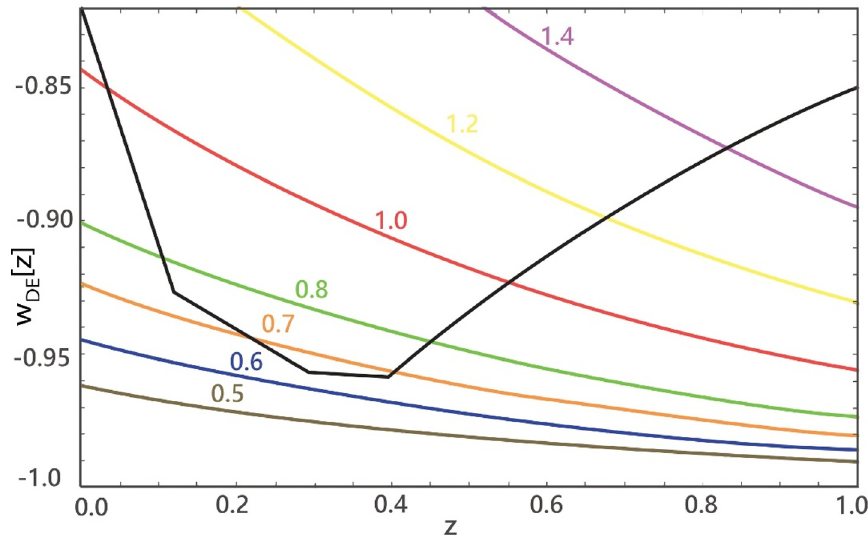
Figure 1 . The black curve shows the current observational 2 (cid:27) bound on w DE ( z ) for redshifts 0 < z < 1 based on SNeIa, CMB and BAO data [27]. This is compared with the predicted w DE ( z ) for exponential quintessence potentials with di(cid:11)erent values of constant (cid:21) under the constraint that (cid:10) DE ( z = 0) = 0 : 7 and assuming (cid:10) DE ( z ) becomes negligible at z > 1. From the plot, it is clear that the upper bound is (cid:21) (cid:24) 0 : 6 (blue